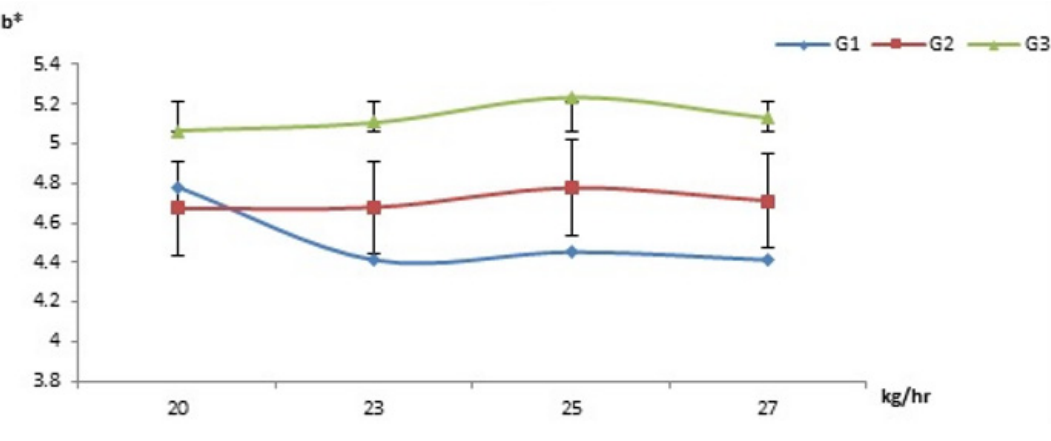
Figure 8. Effect of feed rate on b*.